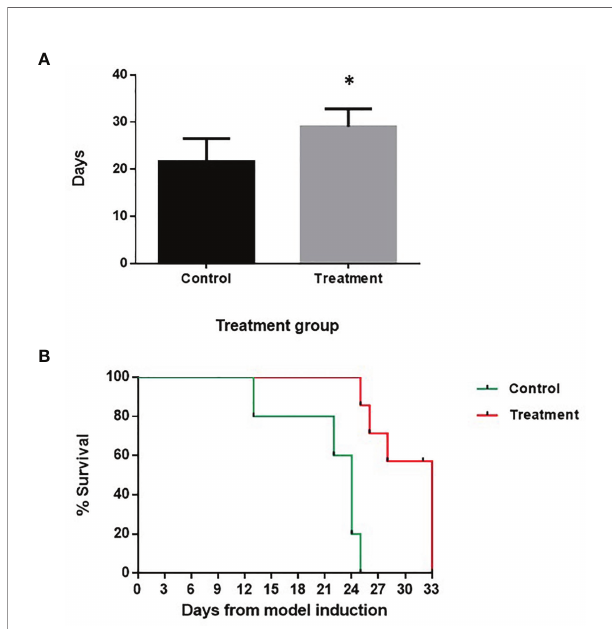
FIGURE 9 | Effect of treatment on animal survival in the 4T1 breast cancer lung metastasis model. Treatment cycles started at day 13 after cell inoculation. (A) Median survival time (days) of control vs . treatment group. (B) Kaplan-Meier survival curve. There was a signi fi cant difference in the survival rate between the two groups. The statistical analysis was performed using the log-rank test, p -value <0.005